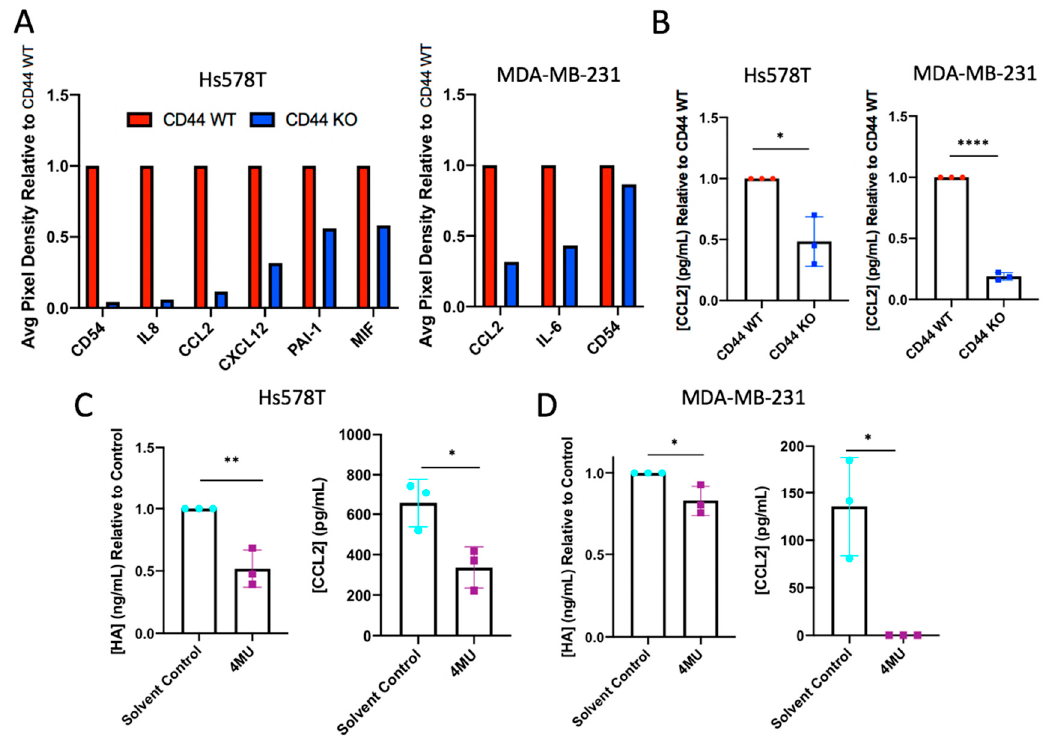
Figure 4. CD44 knockout and hyaluronan depletion from breast cancer cells decrease production of inflammatory cytokines. ( A ) Inflammatory cytokine arrays from Hs578T and MDA-MB-231 cells were used as a screening tool to identify changes within cytokines upon CD44 deletion. Cytokines within conditioned media collected from CD44 WT and KO Hs578T and MDA-MB-231 cells were detected via immunoblotting and chemiluminescence. ( B ) A decrease in CCL2 production upon CD44 deletion was validated in triplicate using an ELISA. HA depletion was verified in ( C ) Hs578T and ( D ) MDA-MB-231 cells following 24 h 600 µ M 4-methylumbelliferone (4MU) treatment. Similarly, cell supernatants were subsequently used to detect changes in CCL2 production via ELISA upon 4MU treatment in ( C ) Hs578T and ( D ) MDA-MB-231 cells. Each experiment was repeated three times represented by each data point. Statistical analysis was performed using Student’s unpaired, two-tailed t -test. Error bars represent standard error of the mean. P values * p < 0.05; ** p < 0.01; **** p < 0.0001.